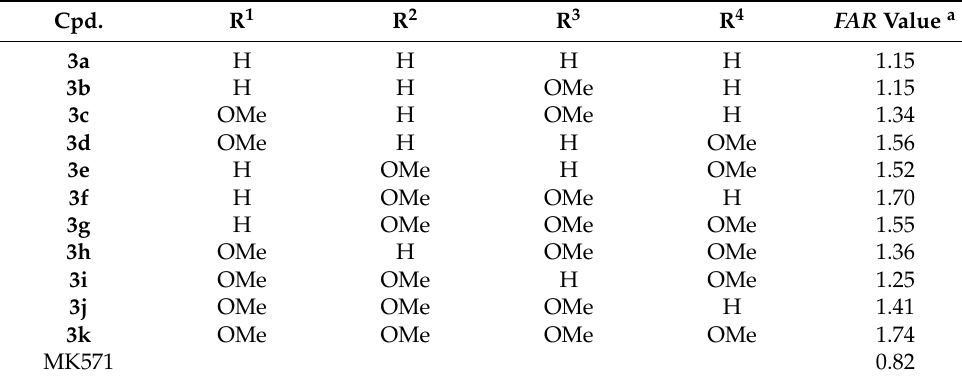
Table 1. MRP4 inhibition data of target compounds 3a – k with varied substitution patterns expressed as FAR